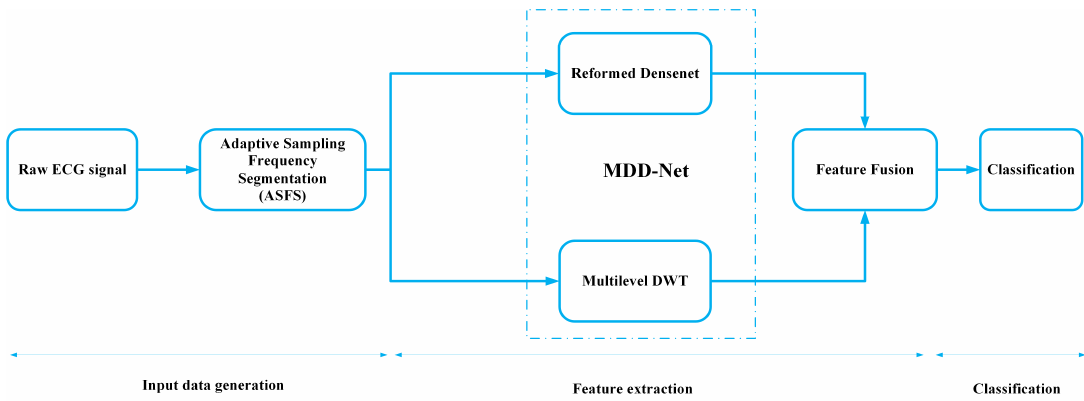
Figure 1. Block diagram of the proposed system.